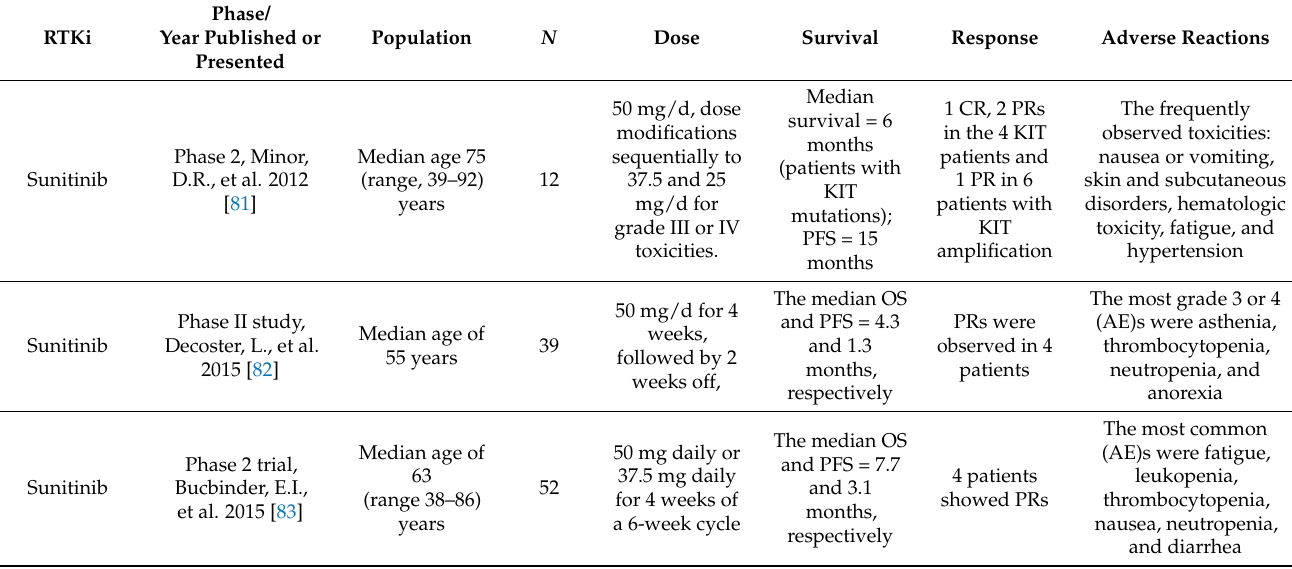
Table 5. Sunitinib in melanoma clinical